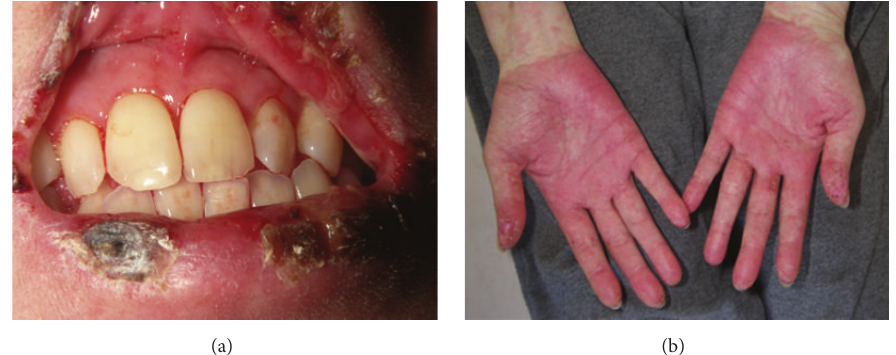
Figure 1: DIHS shows a systemic mucocutaneous disease. (a) Severe erosion with haphalgesia in the entire mouth. (b) Palmar lesion with reddening.